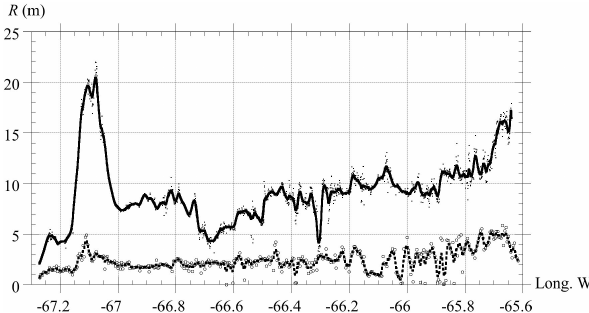
Fig. 16. Comparison of coastal runup along PRNS, for M =9.1 (.——.) and 8.7 (o- - -o) co-seismic tsunami sources in PRT. Com- putations are performed in 3 00 and 15 00 model grids, respectively, us- ing the 3 00 resolution topography and bathymetry depicted in Fig. 5. Solid lines are smoothed representations of the symbols indicating model data